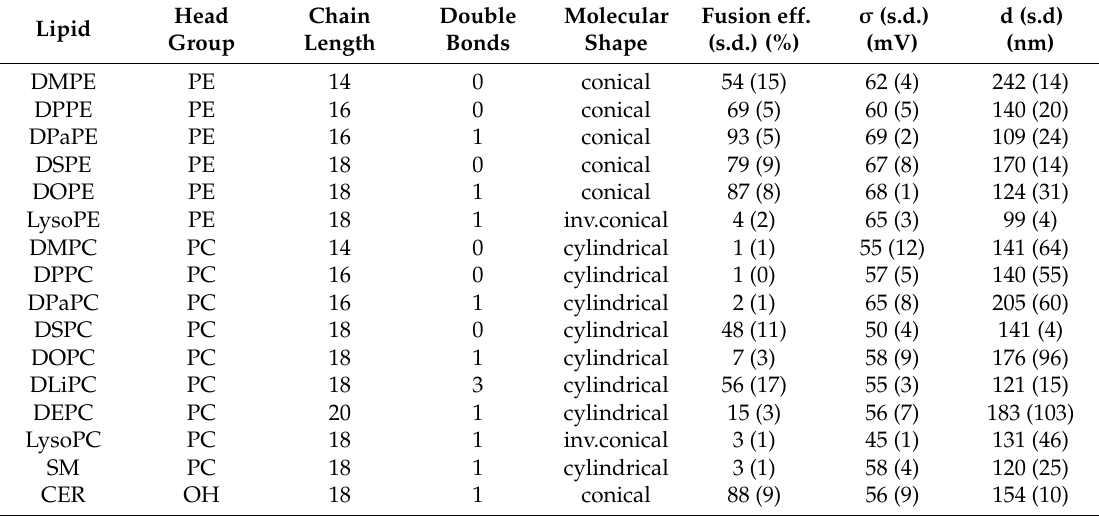
Table 2. Characteristics of liposomes containing different neutral lipids, DOTAP as cationic component, and BODIPY FL-DHPE as fluorescent component (1/1/0.1 mol/mol): head group, chain length, number of double bonds, and molecular shape of the neutral lipid component, fusion efficiency of liposomes with CHO cells, as well as liposomal zeta potential ( σ ), and hydrodynamic size (d). Efficiencies of endocytosis and fusion give together 100%. Average values of at least three independent measurements and their standard deviations are